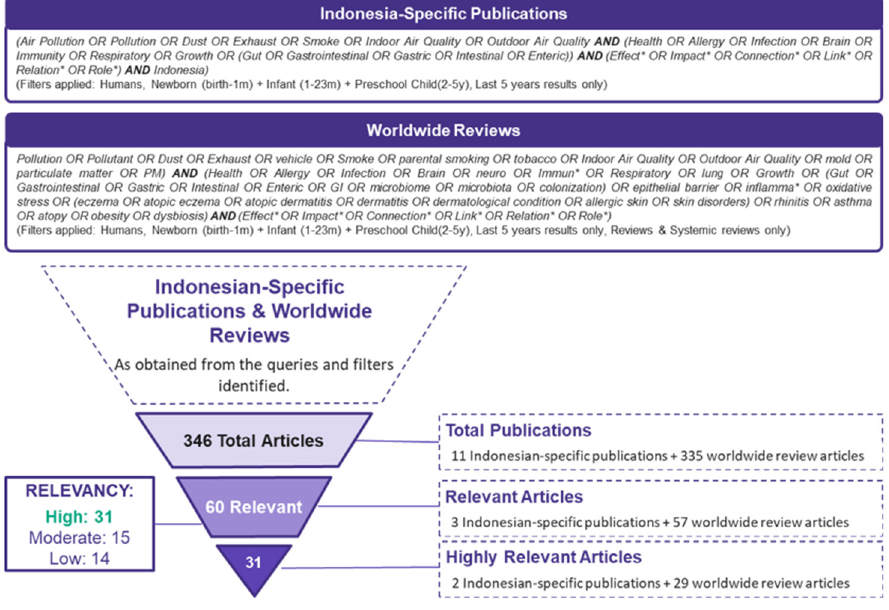
Figure 1. Results of the literature search.